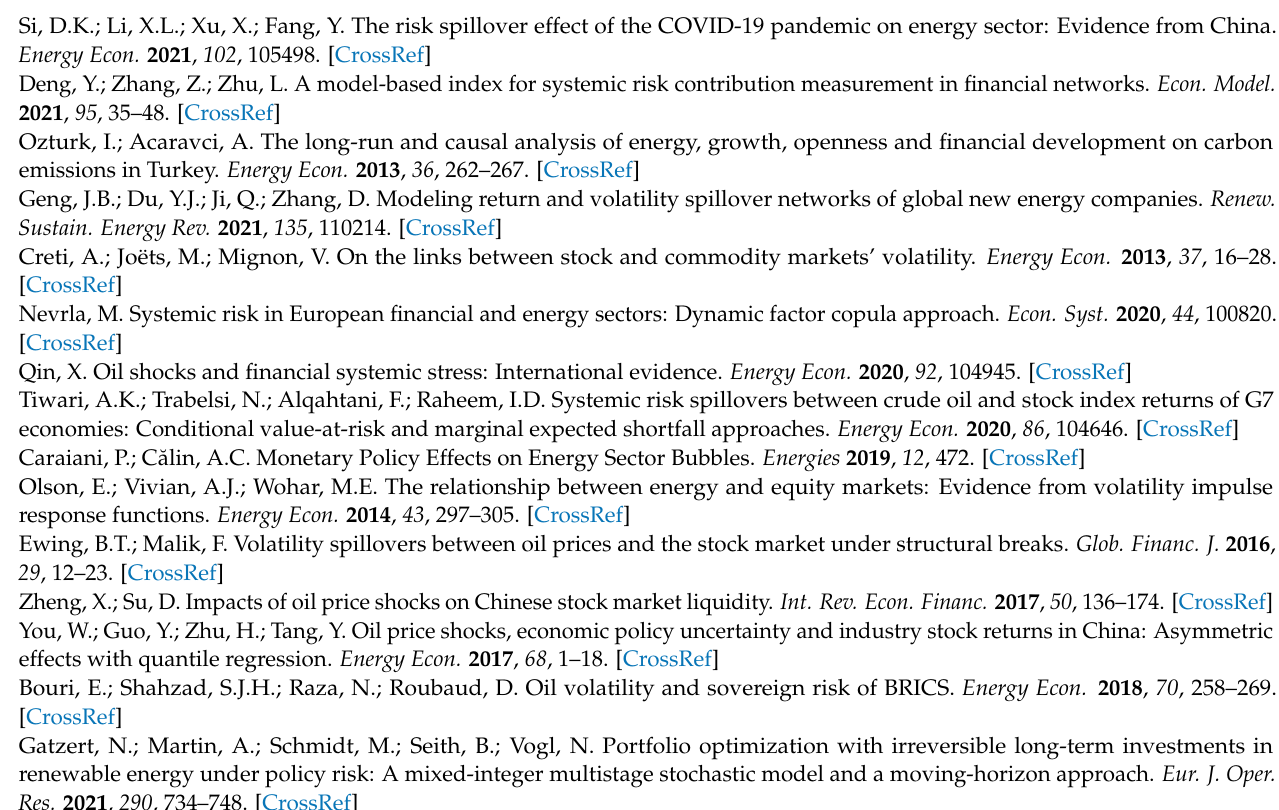
Figure A3. Spillovers (from, to, and net) among companies inside the energy sector for MES measures.